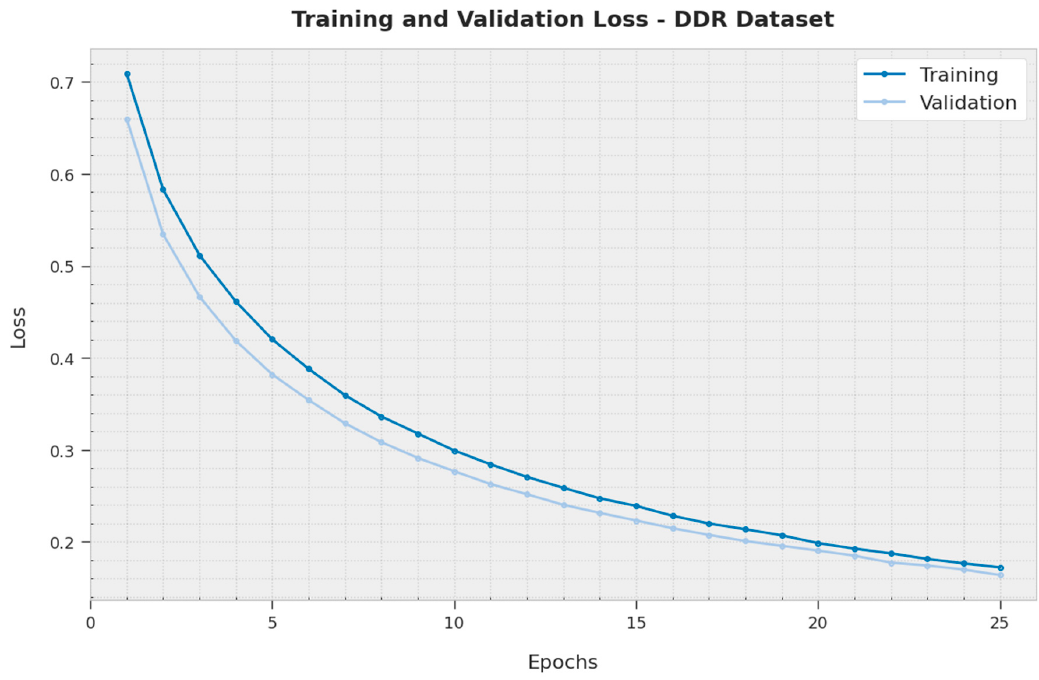
Figure 11. TL and VL analysis of the XAITO-DRGC approach under the DDR dataset.